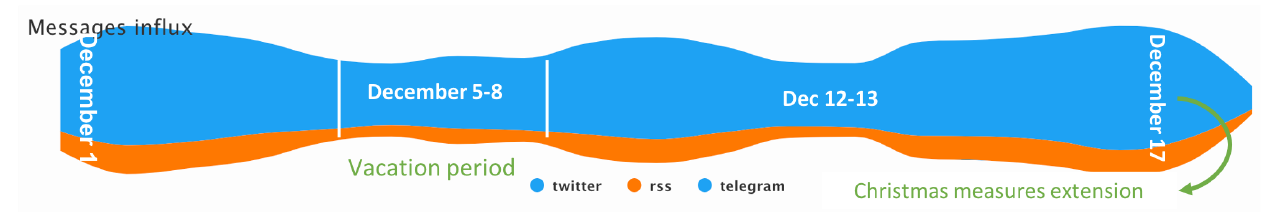
Figure 8. The number of messages on social networks (i.e., Twitter, RSS, and Telegram) about Coronavirus in Spain during the vacation period in December 2020.